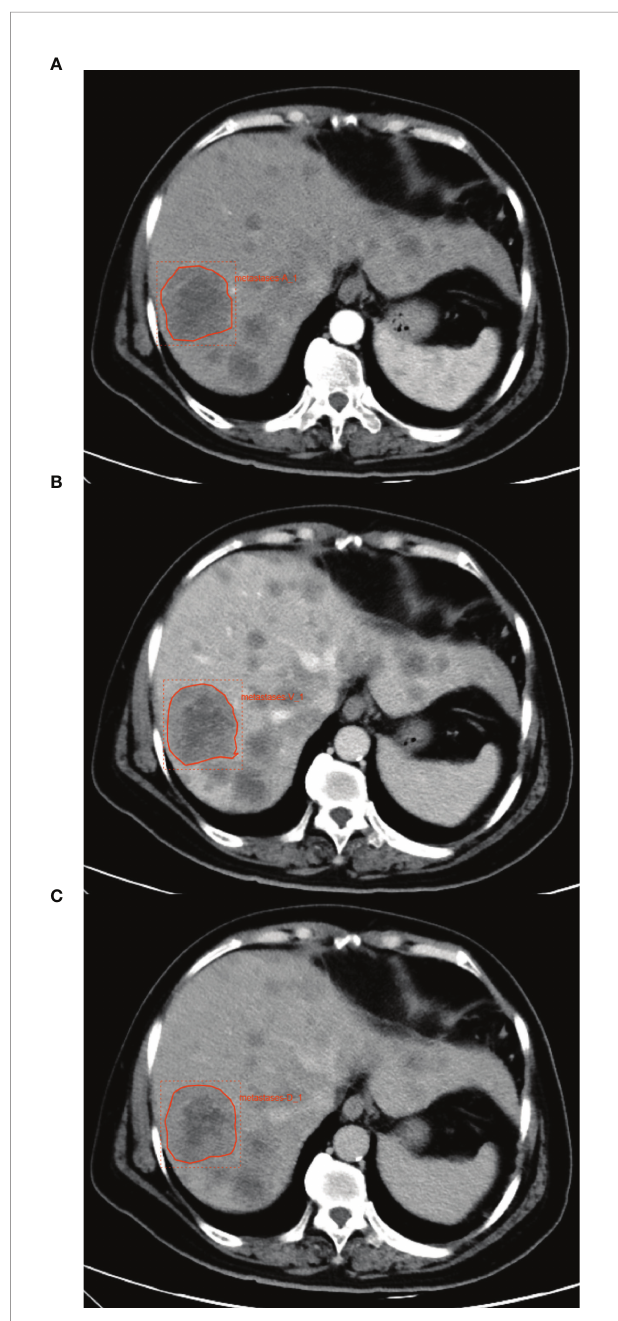
FIGURE 1 | An example of manual segmentation of liver metastases from breast cancer. (A) The ROI in arterial phase. (B) The ROI in portal venous phase. (C) The ROI in delayed